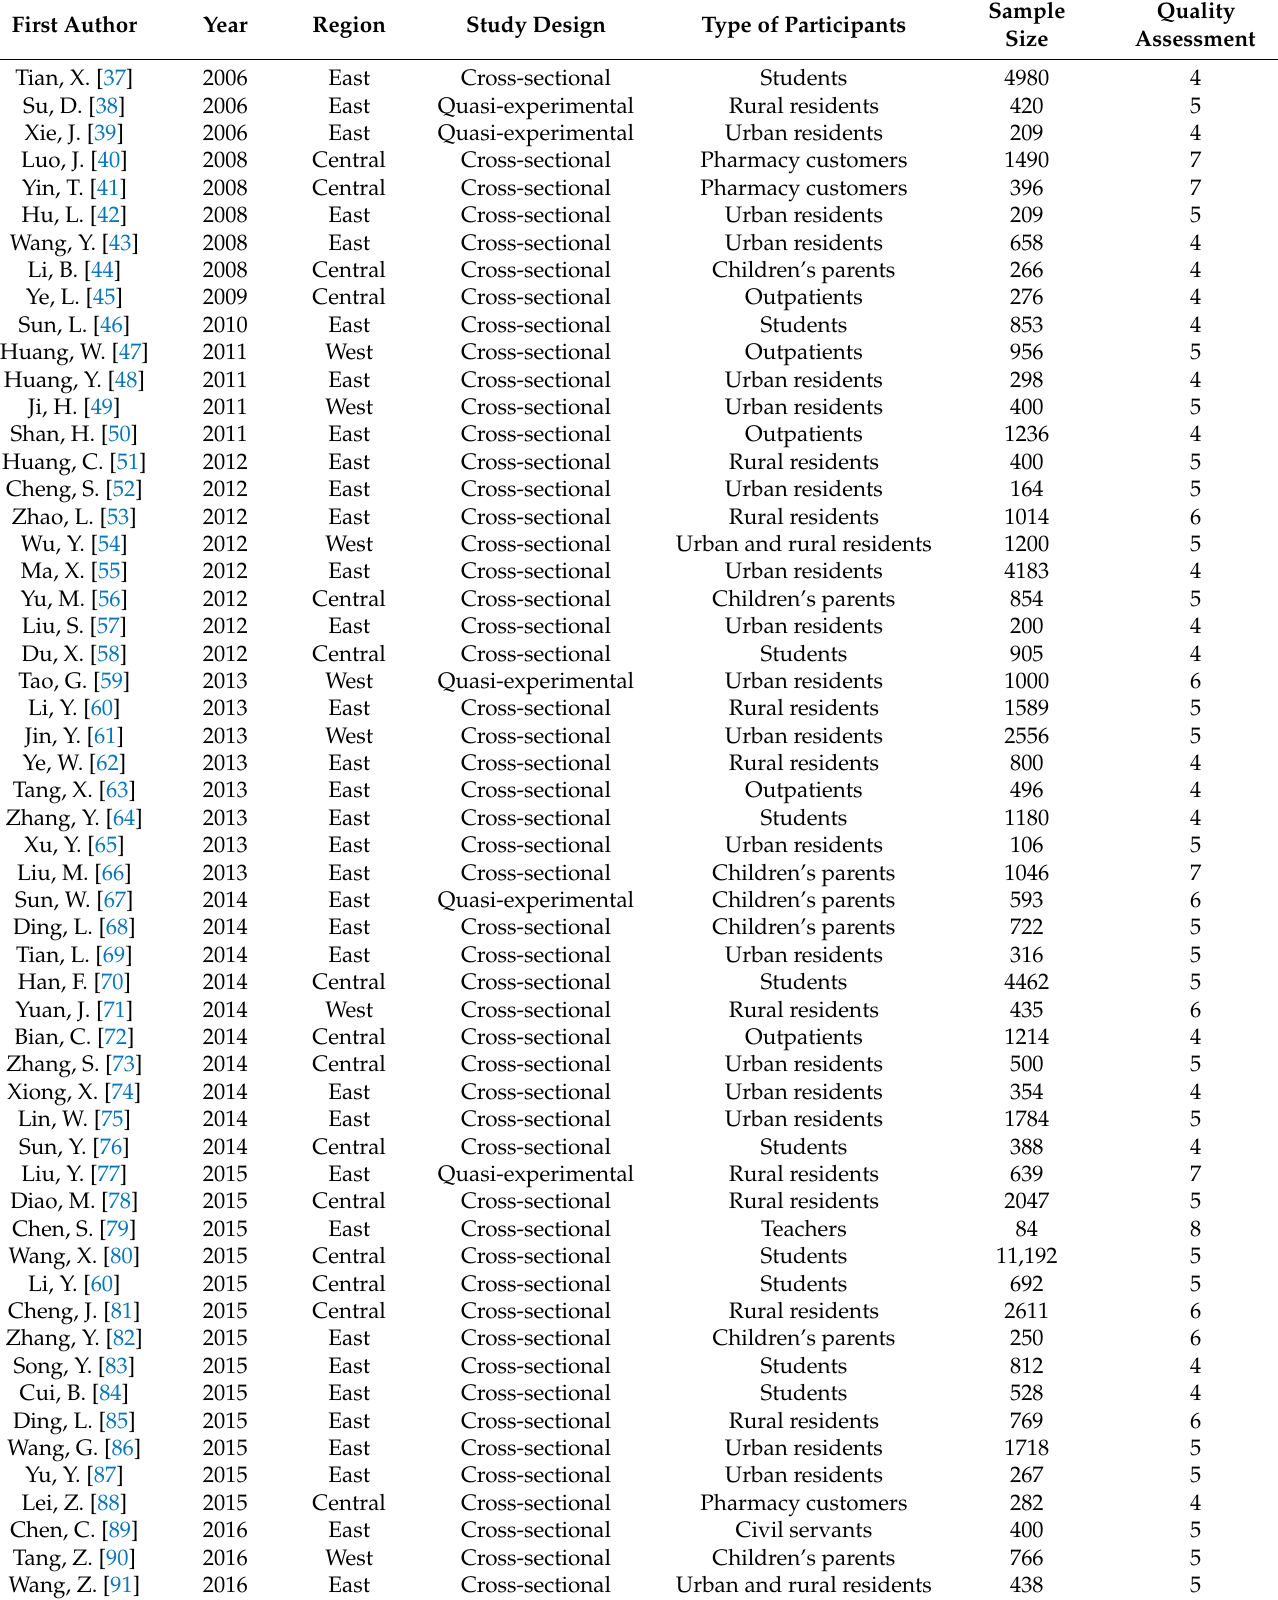
Table 2. Characteristics of the included